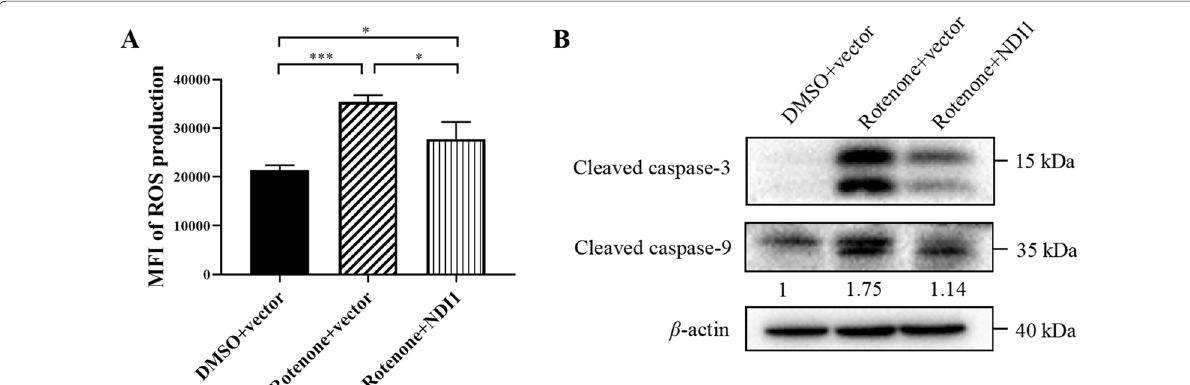
Fig. 4 The mitochondrial ROS level and mitochondria-mediated apoptosis level in rotenone-induced PD cell model transduced with NDI1. A The ROS level in mitochondria was examined by MitoSOX ™ staining. B The mitochondria-mediated apoptosis level was examined by western blot using cleaved caspase-9 antibody and cleaved caspase-3 antibody with β-actin as loading control. MFI: median fluorescence intensity. Rotenone vector + group compared with DMSO vector group, or Rotenone NDI1 group compared with Rotenone vector group, or Rotenone NDI1 group + + + + compared with DMSO vector group, ns not significant. * P < 0.05, ** P < 0.01, *** P < +